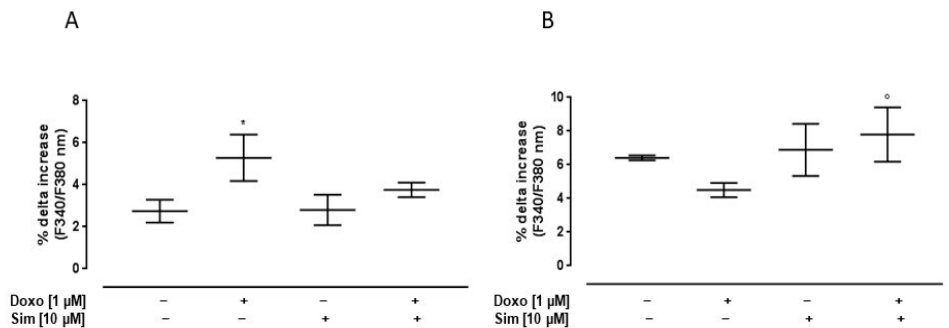
Figure 2. Effect of Simvastatin on Doxorubicin-induced calcium homeostasis dysregulation. H9c2 cells were pre-treated with Sim (10 µ M) for 4 h and then co-exposed to Sim and Doxo (1 µ M) for 20 h. FCCP (50 nM) in calcium-free medium was used to evaluate mitochondrial calcium levels ( A ). Ionomycin (1 µ M) in calcium-free medium was used to evaluate intracellular calcium levels ( B ). Results are reported as mean ± S.E.M. of percentage of delta (% ∆ ) increase in FURA2 ratio fluorescence (340/380 nm) from at least three independent experiments, each performed in